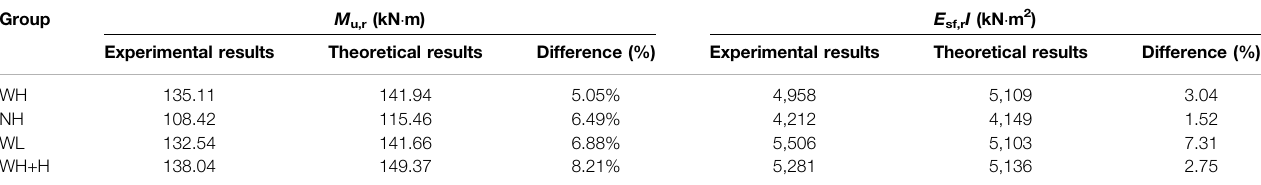
TABLE 7 | Comparison of the theoretical results to the experimental results.